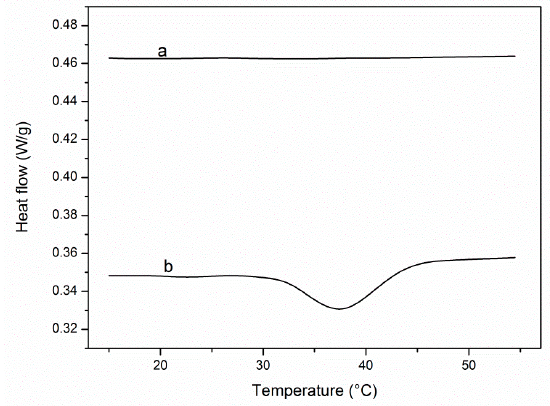
Figure 2. Drilling string compensator curves of different grafted silica. a. NH 2 -grafted silica, b. poly(NIPAAm- co -DEAEMA- co - t BAAm)-grafted silica, the grafting density is 30%.